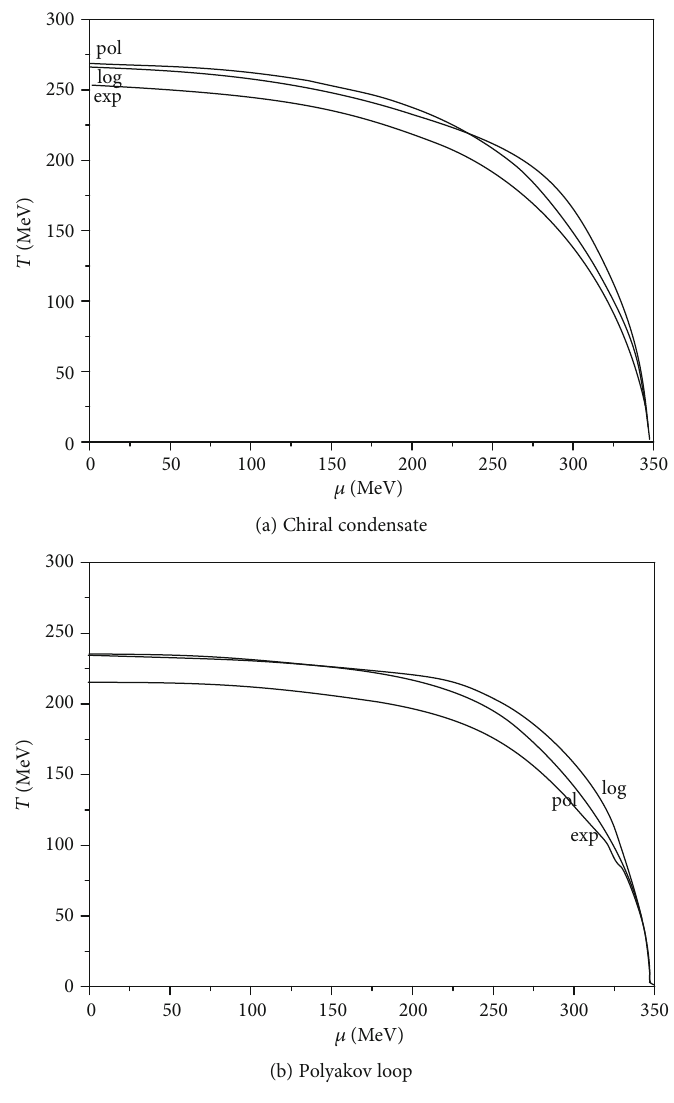
Figure 6: Phase diagram superposition for local criterion. Table 1: Phase diagram results (MeV) obtained for each e ff ective potential ( T = 270 MeV); the critical temperatures are at μ = 0 . 0